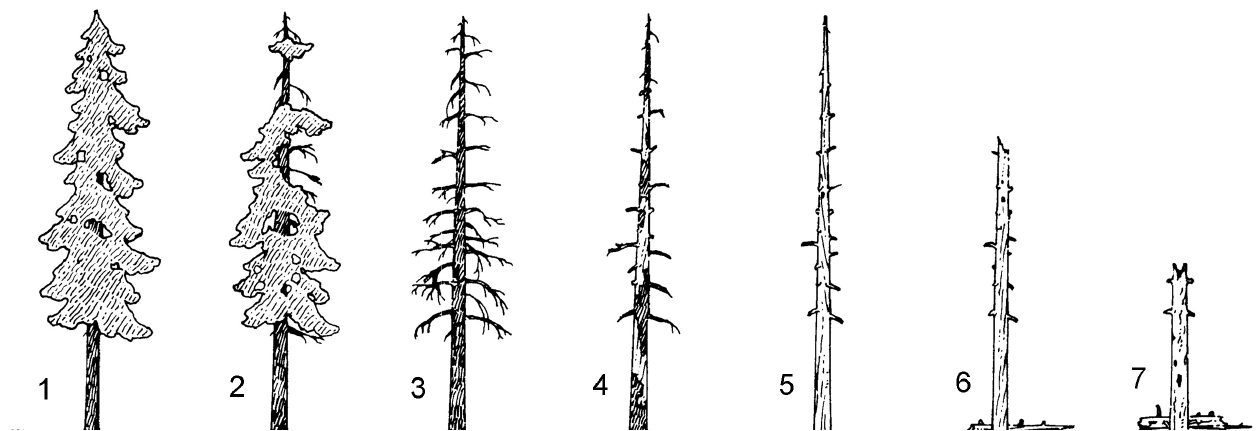
Fig 2. Decomposition stage time sequence continuum of nest trees of northern spotted owls, northwestern United States. Stage number, description, and approximate range of years since tree death are as follows: stage 1–intact crown and loosened bark, 0–6 years; stages 2 and 3–declining crown, broken tops, soft wood, 7–18 years; stage 4–loose bark and wood, only stubs of large limbs remain, 19–50 years; stages 5 and 6–no bark, accumulated wood and bark around tree base, 51–125 years; stage 7–decomposed, (cid:21) 125 years [32, 33]. Stages 1–2 are considered alive, and stages 3–7 are dead trees. Images are not